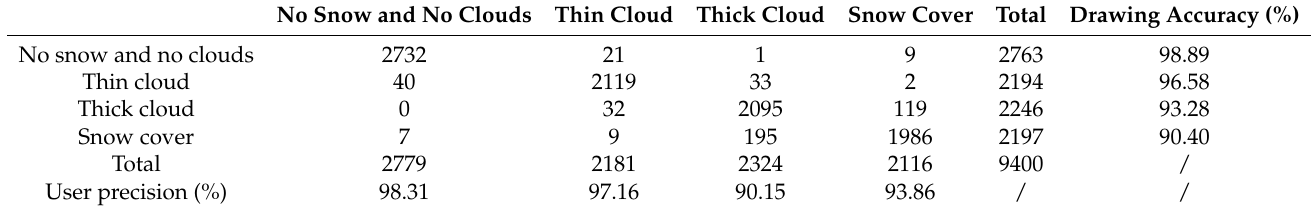
Table 8. Confusion matrix for the results of the lightweight feature mapping attention network